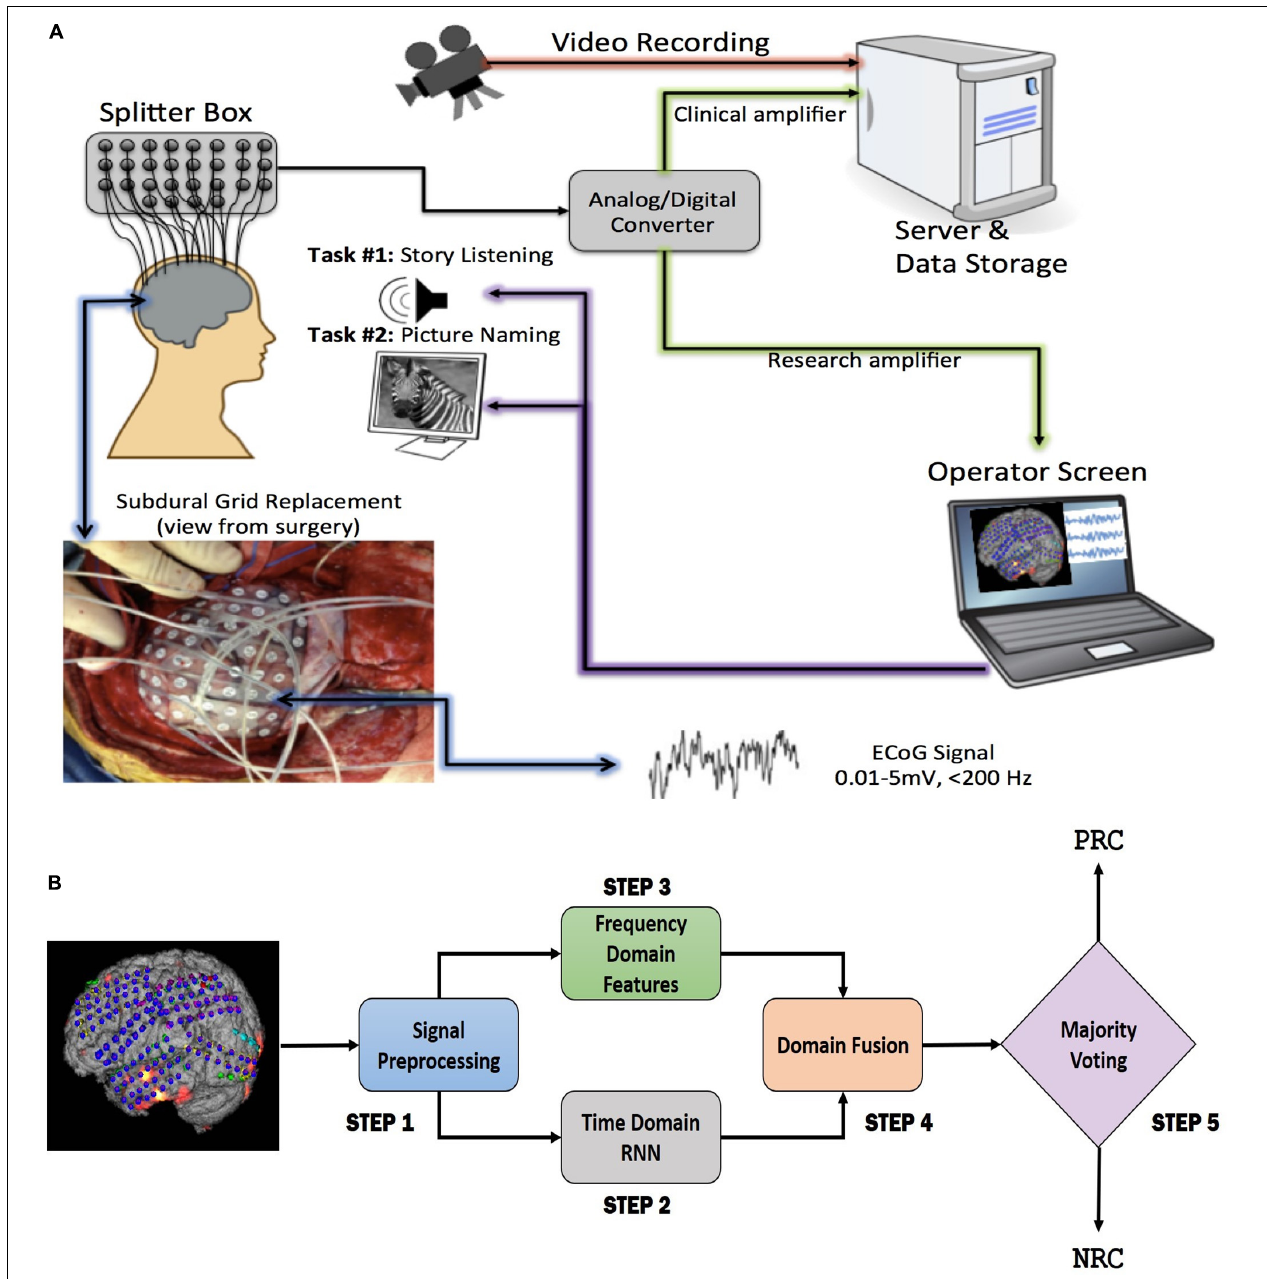
FIGURE 1 | Overview of (A) the language localization framework with ECoG-based functional mapping (ECoG-FM) approach. ECoG signal recording, data transfer, storage, research and clinical paths, and tasks are illustrated. ECoG signals are obtained in response to task-related changes (e.g., picture naming) from grid electrodes implanted on the cortical surface in the subdural space, (B) the proposed ECoG signal classification approach for each channel on the cortical surface in the subdural space. PRC, Positive Response Channel; NRC, Negative Response Channel. Each individual step is considered as a “module” in the overall system design. RNN, Recurrent Neural